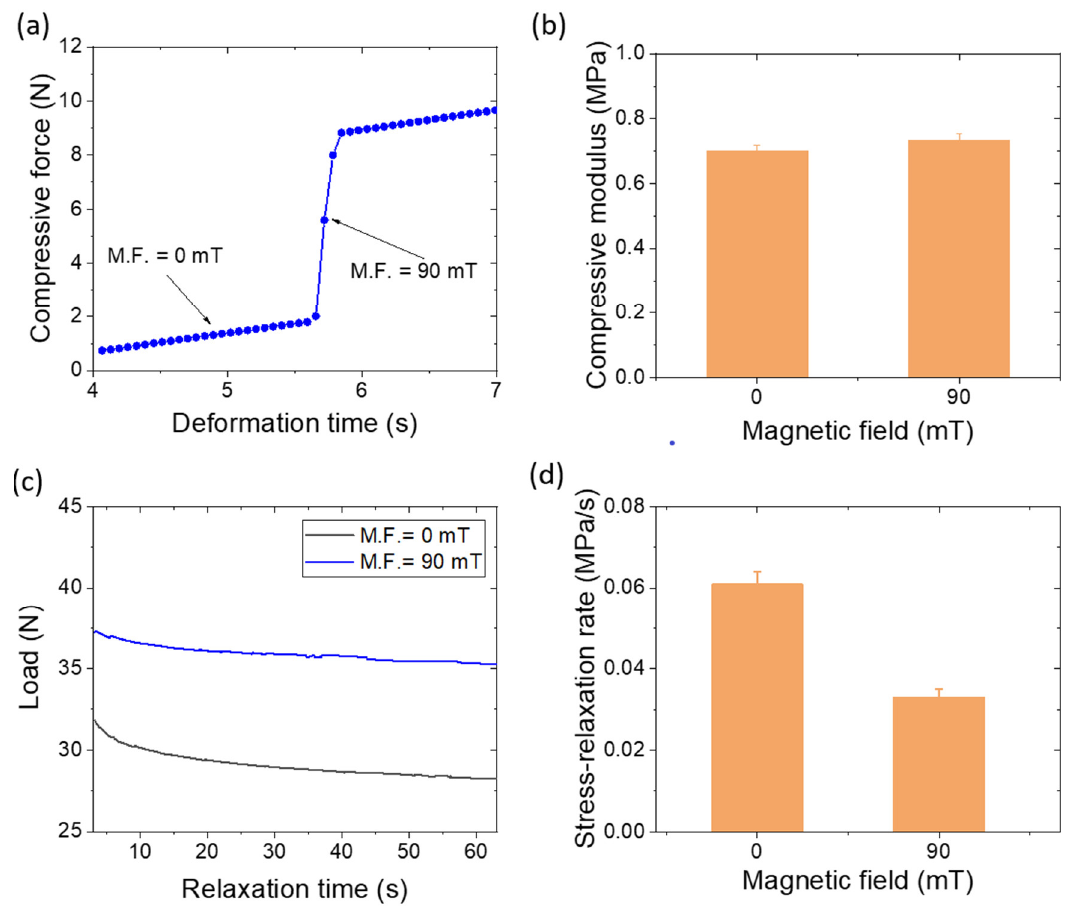
Figure 10. Magneto-mechanical properties of 40 phr Fe 2 O 3 -filled silicone rubber composite; ( a ) compressive force under a magnetic cycle, ( b ) magnetic effect on modulus, ( c ) load relaxation curves within 3–63 s with 10% deformation of cylindrical sample, and ( d ) magnetic effect on the stress–relaxation rate.